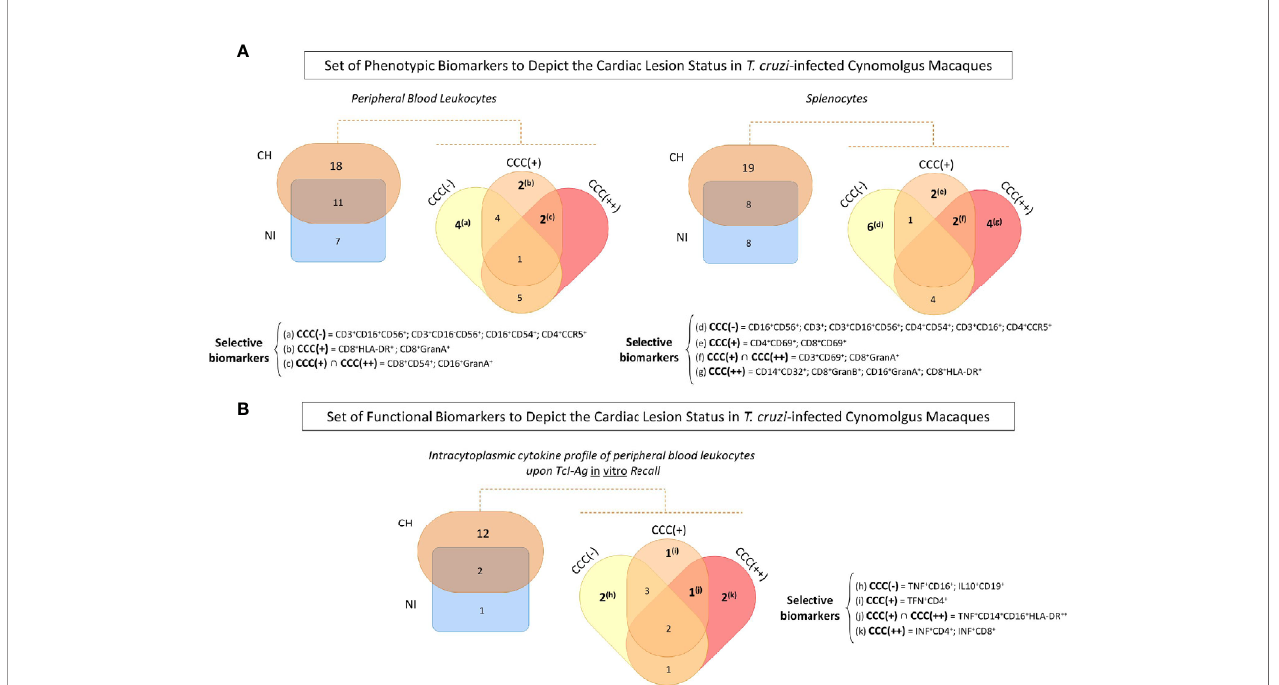
FIGURE 4 | Set of phenotypic/functional biomarkers useful to depict the cardiac lesion status in T. cruzi -infected cynomolgus macaques. (A) Venn diagram analyses were carried out to identify common and selective phenotypic biomarkers in peripheral blood and spleen samples from T. cruzi -infected cynomolgus macaques (CH = ) and non-infected controls (NI = ), and subsequently among subgroups of T. cruzi -infected macaques, classi fi ed according to histopathological features of cardiac biopsies and referred as CCC ( – ) for absence of chronic chagasic cardiopathy ( ); CCC (+) for mild chronic chagasic cardiopathy ( ) and CCC (++) for moderate chronic chagasic cardiopathy (). (B) Venn diagram analyses were performed to select, within the intracytoplasmic cytokine pro fi le of peripheral blood leukocytes upon TcI-Ag recall in vitro , the common and unique functional biomarkers for T. cruzi -infected cynomolgus macaques (CH) and non- infected controls (NI) and subsequently among the CCC ( – ), CCC (+) and CCC (++) groups. The selected sets of biomarkers are shown in the fi gure. Detailed data and conventional statistical analysis is presented in Supplementary Table 1